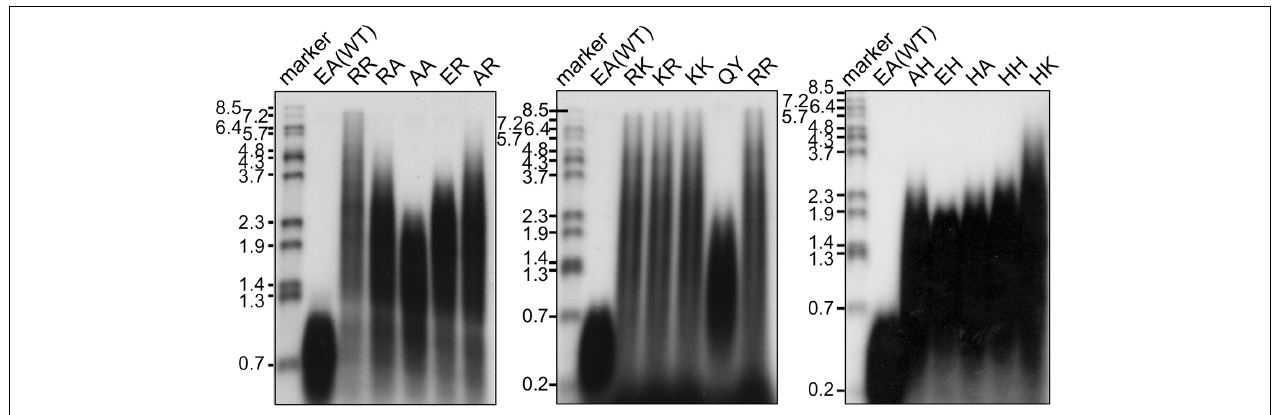
FIGURE 5 | Primer extension activities of WT and mutant Taq polymerases. M13 ssDNA annealed with a 32 P-labeled deoxyoligonucleotide (55mer) was used as the substrate. For each DNA polymerase, 0.05 unit was added to 20 μ l reaction mixture, containing 2.5nM primed DNA. The reaction